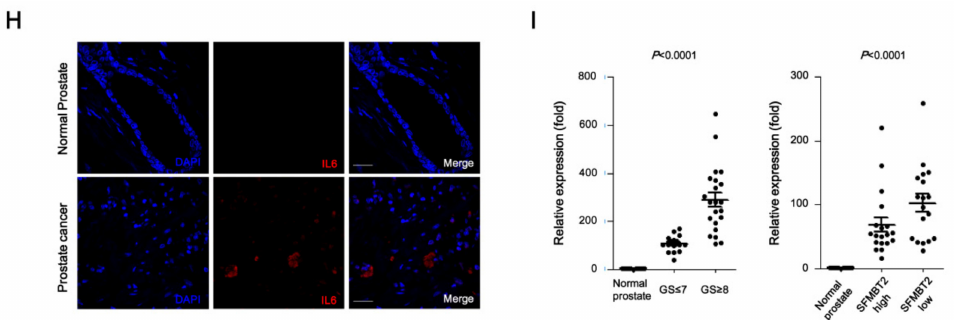
Figure 6. Preadipocytes and TAMs promote migration and invasion of prostate cancer cells through the up-regulation of IL-6. ( A , B ) Culture media (CM) from 3T3-L1 preadipocytes promote migration and invasion of LNCaP cells stably transfected with SFMBT2 shRNA. However, the addition of anti-IL-6 antibody suppresses migration and invasion of LNCaP cells stably transfected with SFMBT2 shRNA. After incubation of LNCaP cells stably transfected with SFMBT2 (shSFMBT2) or control shRNA (shCont) with anti-IL-6 antibody in culture media from 3T3-L1 preadipocytes, transwell assay was performed. Migrating or invading LNCaP cells were counted. ( C , D ) Culture media from TAMs polarized from Raw264.7 cells promote increased migration and invasion of LNCaP cells stably transfected with SFMBT2 shRNA. However, the addition of the anti-IL-6 antibody suppresses migration and invasion of LNCaP cells stably transfected with SFMBT2 shRNA. After incubation of LNCaP cells stably transfected with SFMBT2 (shSFMBT2) or control shRNA (shCont) with anti-IL-6 antibody in culture media from TAMs, transwell assay was performed. Migrating or invading LNCaP cells were counted. ( E , F ) Increased expression of IL-6 in 3T3-L1 preadipocytes and TAMs polarized from Raw264.7 cells incubated with culture media from LNCaP cells stably transfected with SFMBT2 shRNA. RNA was analyzed. ( G ) Increased expression of IL-6 in prostate cancer induced by intraprostatic injection of LNCaP cells stably transfected with SFMBT2 shRNA. LNCaP cells (1 × 10 6 cells) stably transfected with control or SFMBT2 shRNA were injected into the prostate (dorsal lobe) of nude mice (n = 3 / group). At week 5 post-injection, the prostate was harvested, fixed, sectioned, and immunostained with the anti-IL-6 antibody. Representative images are shown. Nuclei were identified using DAPI staining. Scale bar, 25 µ m. Expression was quantified using the ImageJ program. ( H ) Increased expression of IL-6 in prostate cancer tissues of patients. Immunohistochemical staining of a tissue array from prostate cancer patients was performed using the anti-IL-6 antibody. Representative images are shown. Nuclei were identified using DAPI staining. Scale bar, 25 µ m. Expression was quantified using the ImageJ program. ( I ) Proportional relationship of Gleason scores (GS) with the expression level of IL-6 in prostate cancer tissues of patients. Inverse relationship of SFMBT2 expression with the expression level of IL-6 in prostate cancer tissues of patients. All data represent mean ± S.E.M. Significance values were ** p ≤ 0.01 and *** p ≤